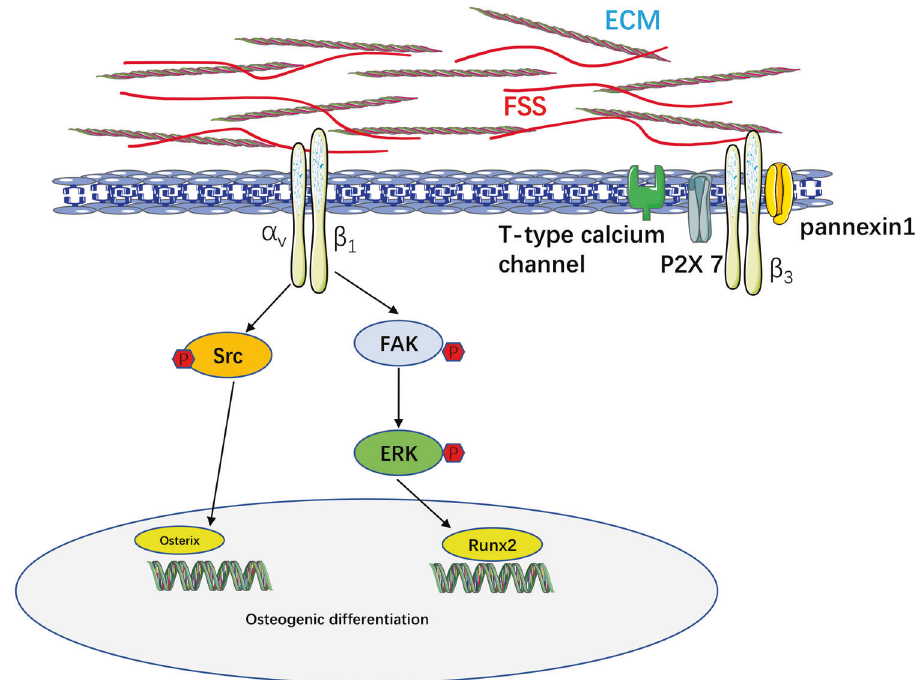
Fig. 2 Integrins mediate FSS to regulate bone metabolism. FSS activates integrin α v β 1 and promotes Src, FAK, and ERK phosphorylation to enhance osteogenic differentiation. After FSS stimulation, a large number of ion channels are located around β 3 integrin in the osteocyte membrane, forming a potential mechanical conduction complex.